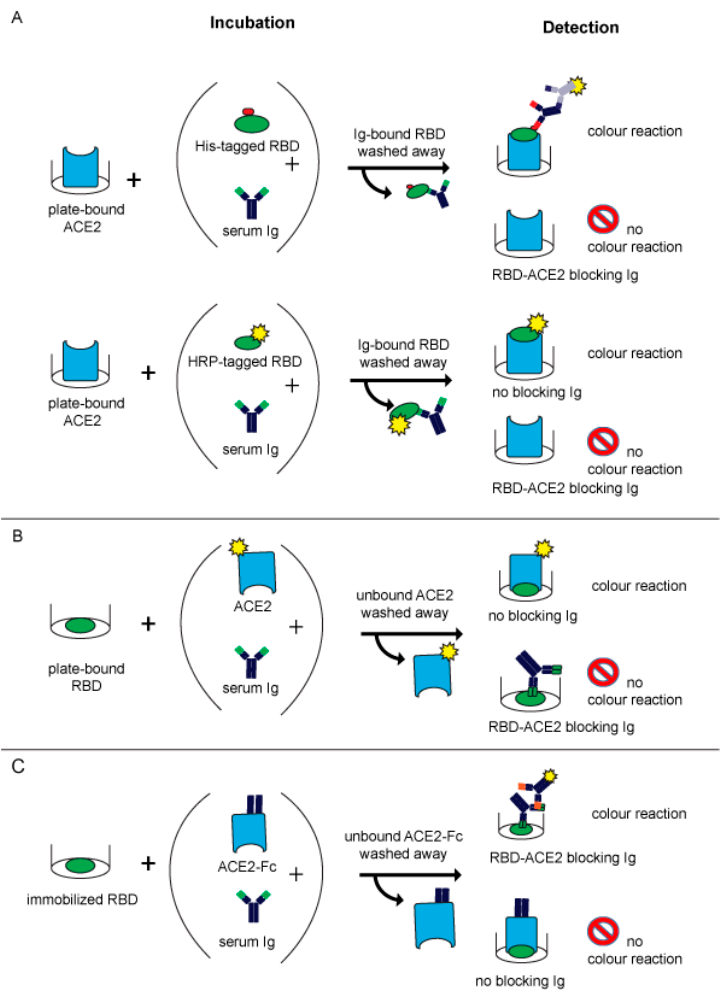
Figure 2. Schematic overview of test principles used in molecular assays mimicking SARS-CoV-2 infections. There are basically two types of assays measuring the interaction of RBD and ACE2 and the ability of antibodies to prevent this interaction. As shown in ( A ), one possibility is that ACE2 is immobilized and differently labelled forms of RBD are incubated with serum. The other possibility as shown in ( B ) is that immobilized RBD is incubated with a mix of soluble ACE2 and serum. Blocking antibodies are detected as a loss or reduction in signal caused by the reduced binding of labelled ACE2 to RBD. ELISA-based competition assays as shown in ( C ) use immobilized RBD. After simultaneously adding ACE2 and serum, blocking antibodies competing with ACE2 for binding to RBD are detected via colorimetric